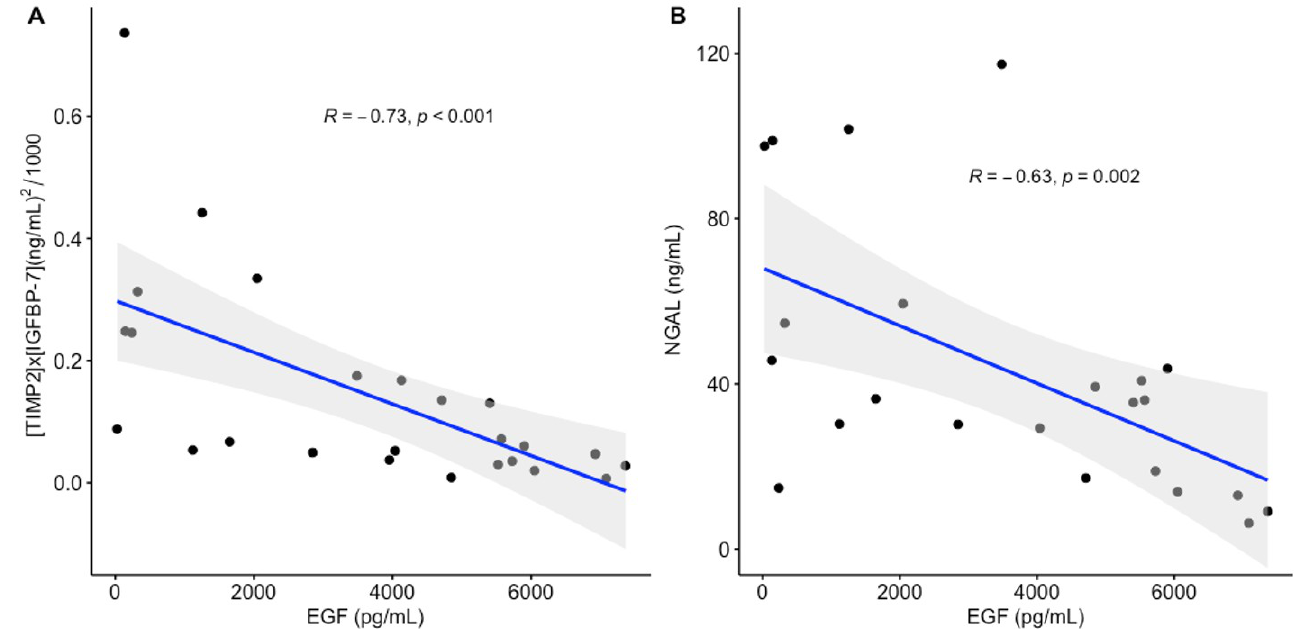
Figure 2. Correlation of urinary EGF with kidney stress biomarkers. ( A ) EGF had an inverse correlation with (tissue inhibitor of metalloproteinases-2, TIMP2) × (insulin-like growth factor binding protein, IGFBP7) ( R = − 0.73, p < 0.001); ( B ) EGF had an inverse correlation with neutrophil gelatinase-associated lipocalin, NGAL ( R = − 0.63, p = 0.002).